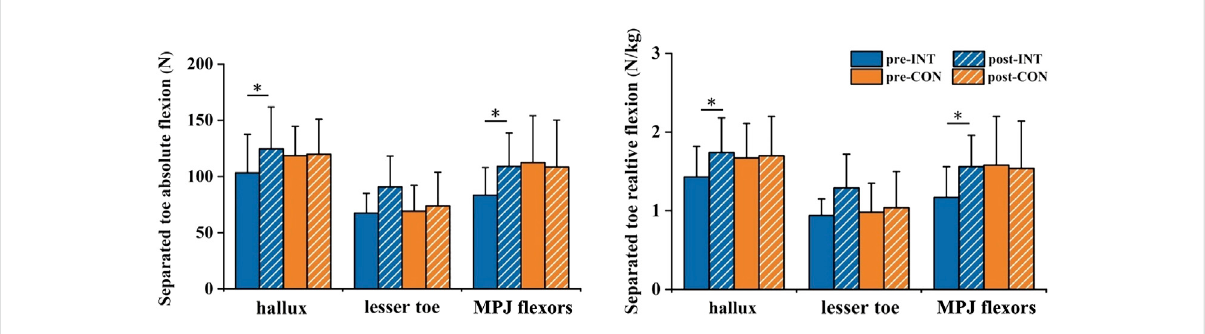
FIGURE 8 Effects of a 12-week gait retraining program combined with foot core exercise on arch muscles strength. Notes: * signi fi cant difference from pre- to